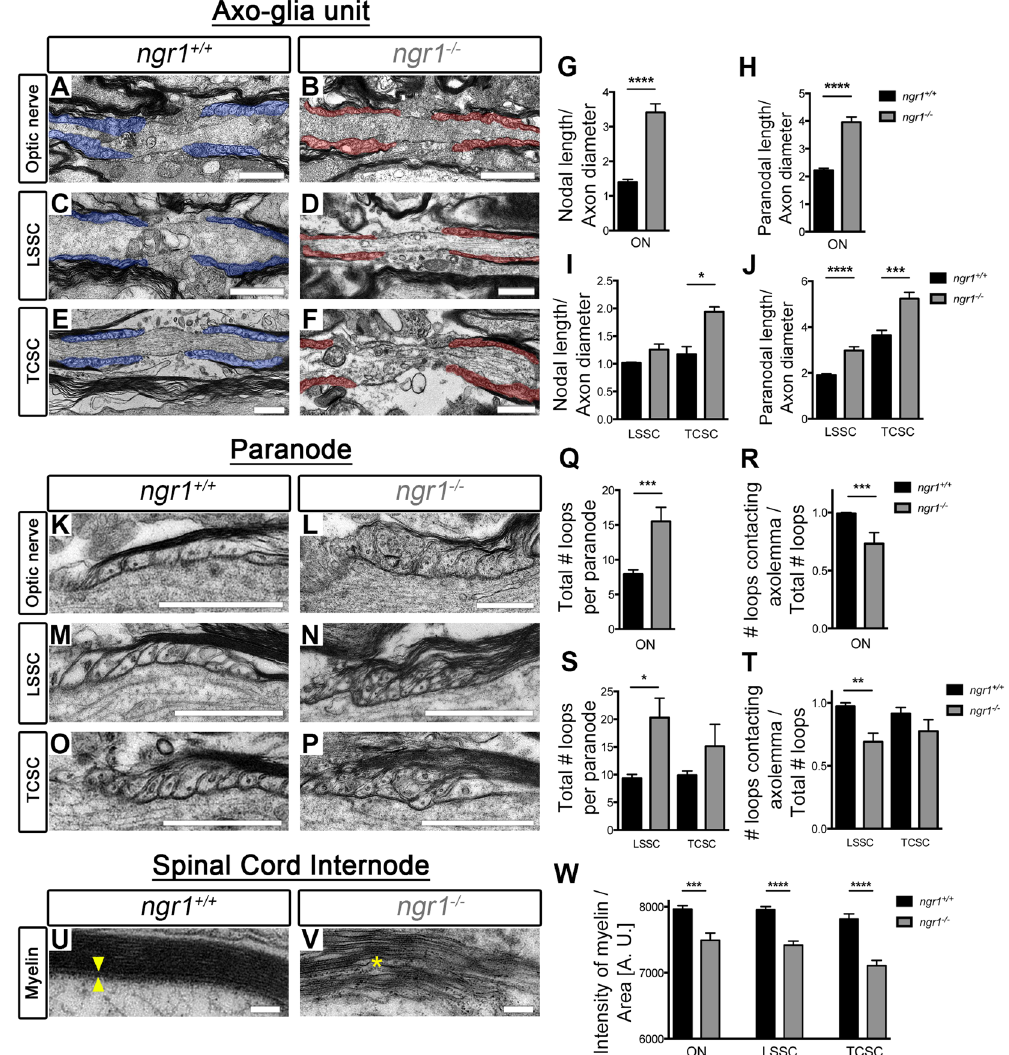
Figure 1. Axo-myelin ultrastructure in ngr1 − / − optic nerves and spinal cords. ( A – F ) Representative EM images of longitudinal sections of ( A , B ) optic nerve (ON), ( C , D ) dorsolateral white matter LSSC, and ( E , F ) TCSC from ngr1 + / + and ngr1 − / − mice showed elongated paranodes in ngr1 − / − (pseudo-coloured in red) compared to ngr1 + / + (pseudo-coloured in blue) (scale bar = 1 μ m). ( G – J ) The ratio between nodal length and axon diameter in ( G ) ON and ( I ) TCSC. ( I – J ) The ratio between paranodal length and axon diameter of ( I ) ON, ( J ) LSSC, and TCSC of ngr1 + / + and ngr1 − / − mice. ( K – P ) High magnification EM images of ( K , L ) ON, ( M , N ) LSSC, and ( O , P ) TCSC longitudinal sections showed a dysregulated formation of paranodal segments in ngr1 − / − mice (scale bar = 1 μ m). ( Q , S ) Total number of paranodal loops of ngr1 + / + and ngr1 − / − mice. ( S , T ) The ratio between number of paranodal loops that are in contact with the axolemma and total number of loops of ngr1 + / + and ngr1 − / − mice. ( U , V ) High magnification EM images of internodal regions of the LSSC showed a lack of intraperiodic lines (yellow arrowhead), and evident intramyelinic vacuoles (yellow asterisk) in ngr1 − / − mice (scale bar = 100 nm). ( W ) The ratio between intensity of uranyl acetate (myelin sheath) and the area of myelin sheath ( * P < 0.05, ** P < 0.01 *** P < 0.001, **** P < 0.0001, n = 8 for both